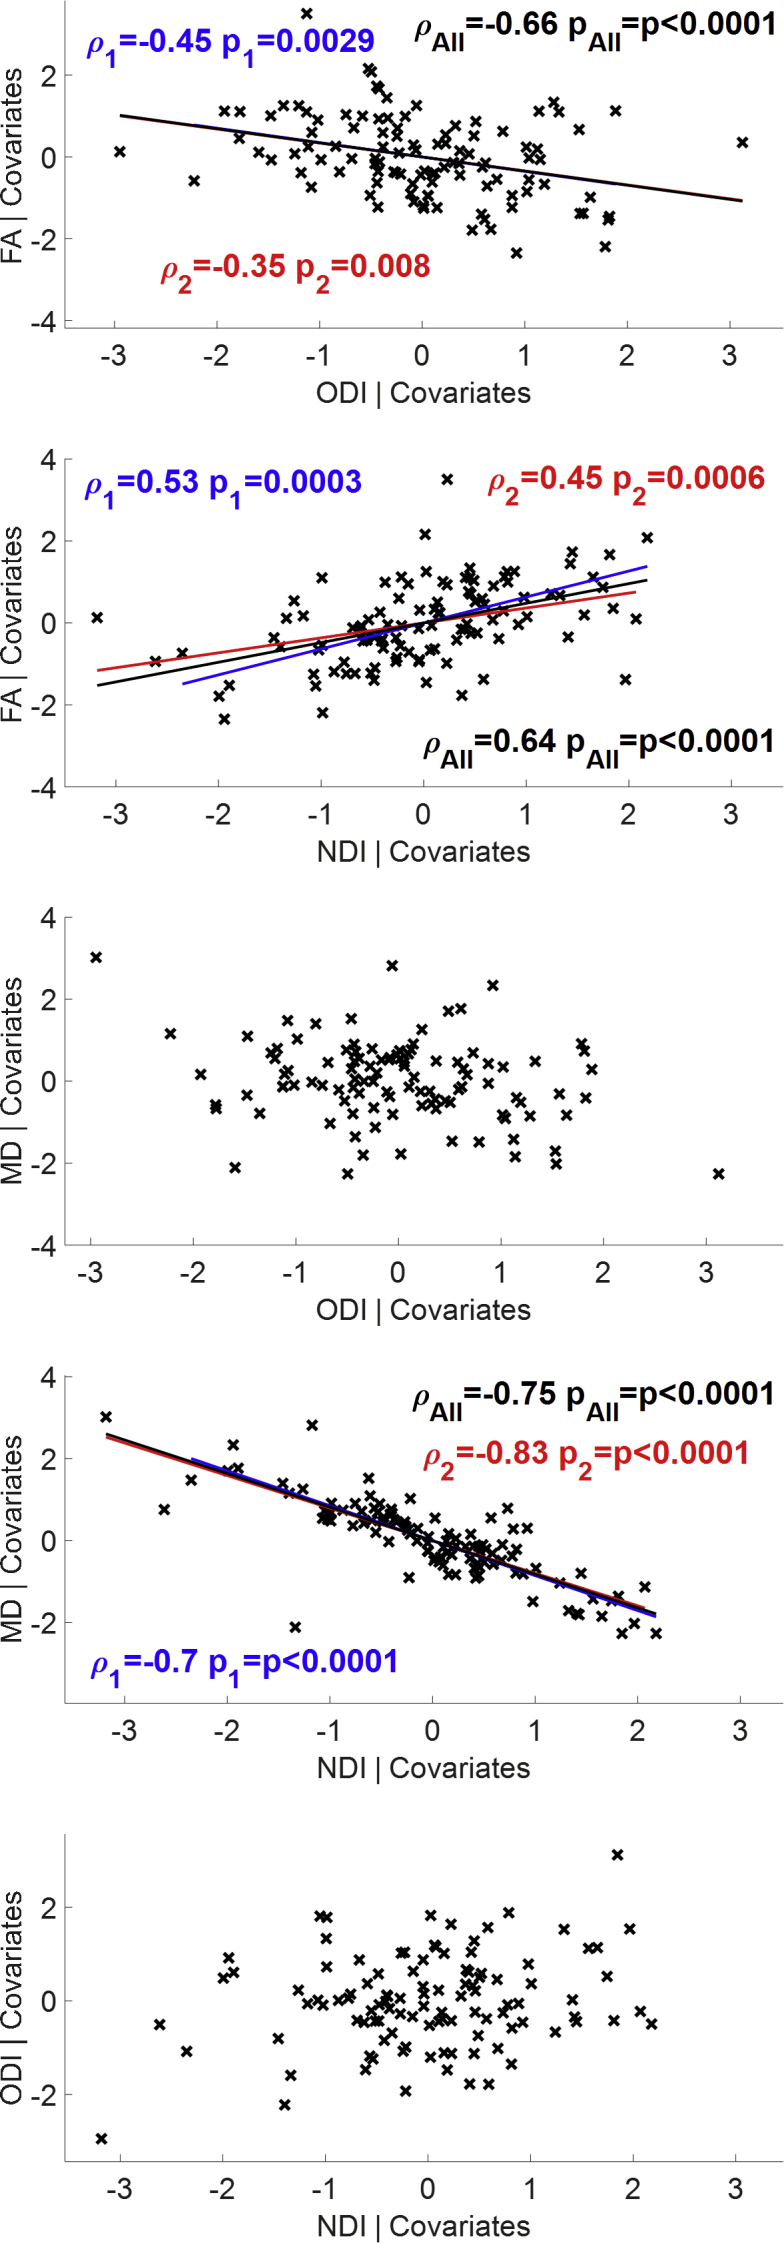
Spearman partial correlations of the residuals of DTI and NODDI features controlling for covariates (including PMA) for whole-brain grey matter tissue. Significant correlations are indicated with regression lines for subjects <38 weeks PMA (1, blue), >38 weeks PMA (2, red) or the whole sample (all, black line).